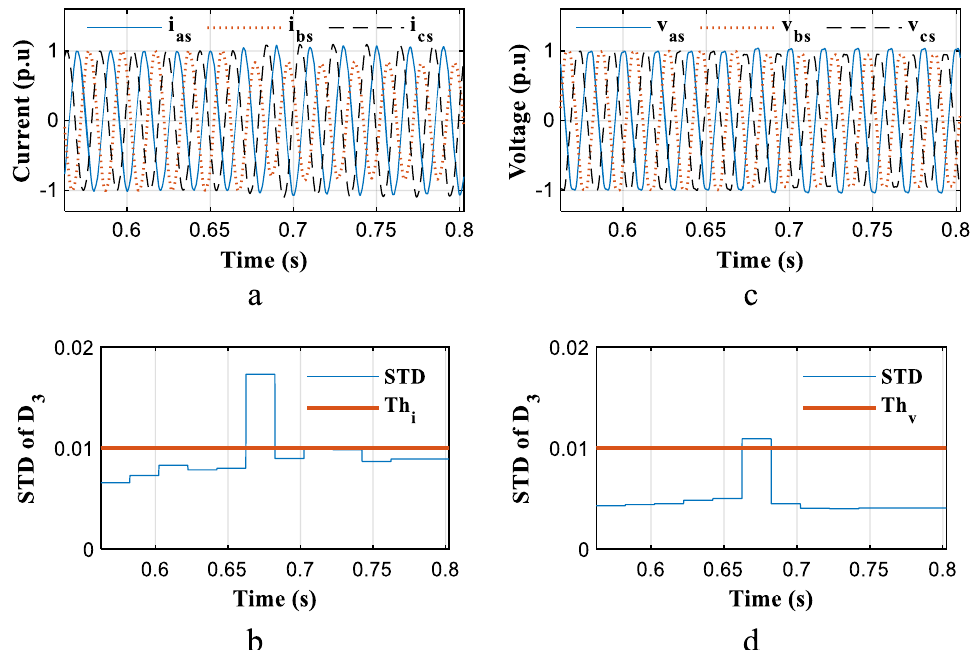
Fig. 19 Performance evaluation of proposed criteria using practical results for a voltage swell 10%, a Three-phase stator current signals, b The current criterion, c Three-phase stator voltage signals, d The voltage